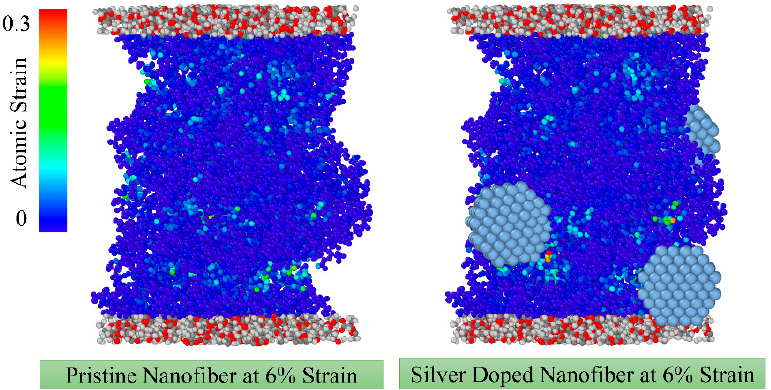
Figure 9. The effect of doping nanoparticles on the distribution of atomic strain in the elastic regime.